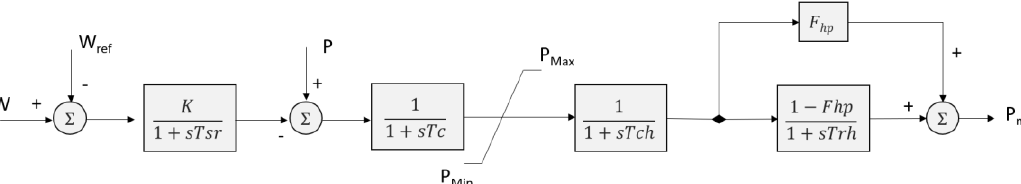
Figure A4. Hydro turbine governor type GovHydroIEEE0 (adopted by [57]).